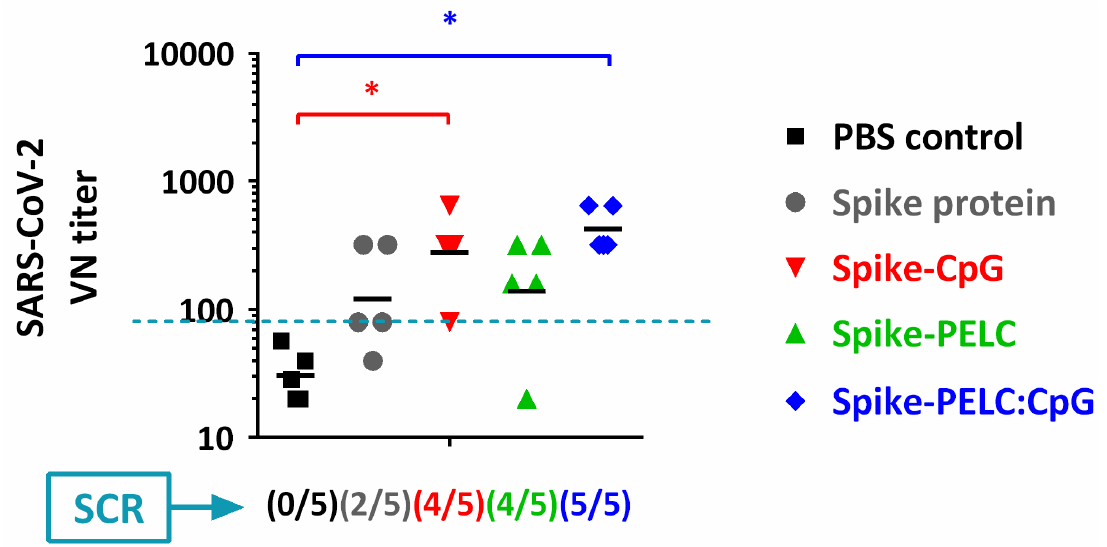
Figure 3. SARS-CoV-2 virus neutralizing (VN) responses following three intranasal doses of PELC:CpG-formulated S protein in BALB/c mice. Mice ( n = 5) were intranasally (i.n.) administered full-length SARS-CoV-2 spike subunit protein, either with CpG, PELC, or their combination. At week 2 and week 4, all mice were boosted i.n. with the same vaccine formulations. The VN antibodies in serum samples at week 5 are expressed as the individual values with the GMT. The seroconversion rate (SCR) was calculated from the proportion of mice with a more than 4-fold increase between pre-vaccination and postvaccination antibody titers. The log-transformed values of antibody titers were compared by employing ANOVA model followed by Bonferroni’s multiple comparison test. * p < 0.05. The dashed line represents seroconversion.